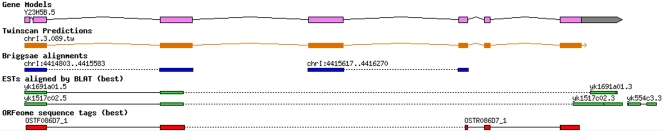
Incorrect C. elegans gene annotation determined by inspection of intron lengths.This gene prediction contained an incorrect in-frame intron sequence in the first exon. Transcript evidence, homology evidence from C. briggsae, and an alternative gene prediction (Twinscan) suggested that the first intron is an annotation error. Image taken from Genome Browser display of WormBase release WS180 (http://ws180.wormbase.org).